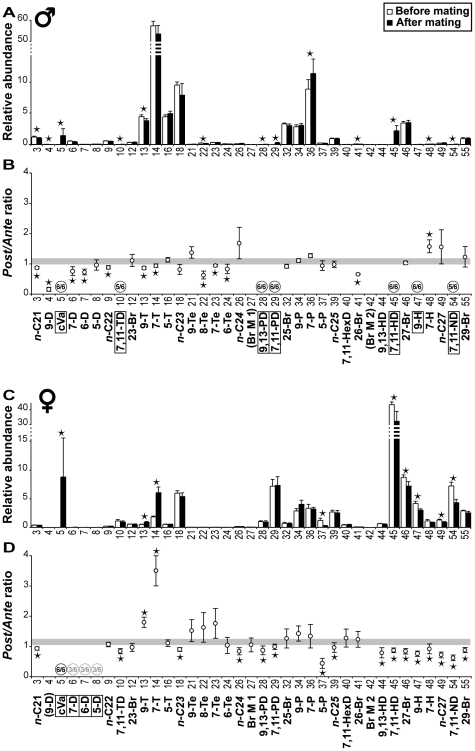
Mating effects on cuticular compounds.(A & C) Global effects. Data shown represent the mean (± SEM) for the relative abundance of cuticular compounds in 4-day-old virgin (empty bars) and in 6-day-old mated (filled bars) males (A) and females (C). n = 6. (B & D) Individual effects. Data shown represent the mean (± SEM) for the Post/Ante ratio (after/before mating) calculated for each compound in individual males (B) and females (D). The confidence limits of the Post∶Ante ratios calculated for the mating effect (shaded stripe) ranges from 0.968 to 1.212 in males, and from 1.037 to 1.253 in females. The compounds in parentheses were not detected in either sex; those shown within a frame appeared during mating. The numbers inside the circle (above the baseline) indicate the proportion of individuals in which they appeared; the grey circles labelled with “3/6” indicate the compounds that appeared in only 50% of mating females. For statistics, see fig. 2.